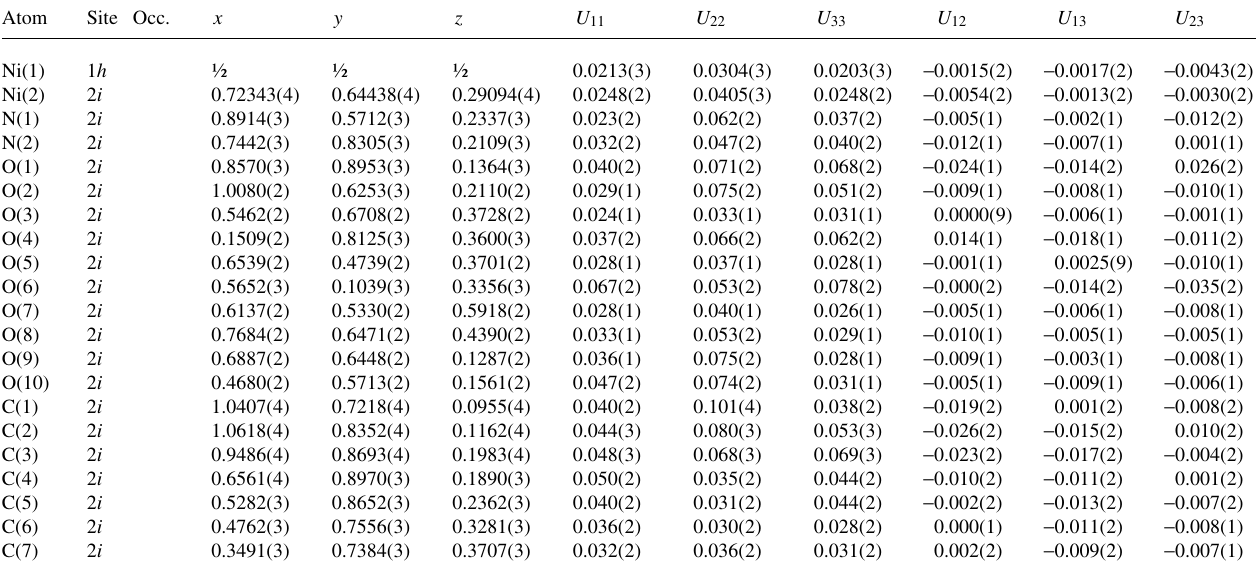
Table 3. Atomic coordinates and displacement parameters (in Å 2 ) .